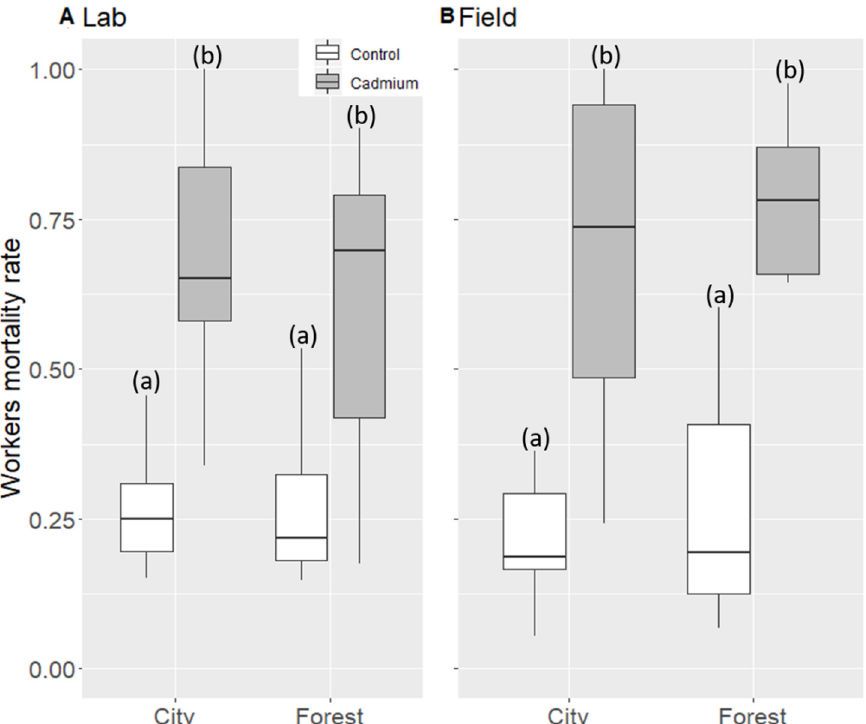
Figure 1. Worker mortality rate in control (white) or cadmium (gray) treatment for lab ( A ) and field hibernation conditions ( B ). For each box, median and quartiles are shown. Different letters represent significant differences (a, b).